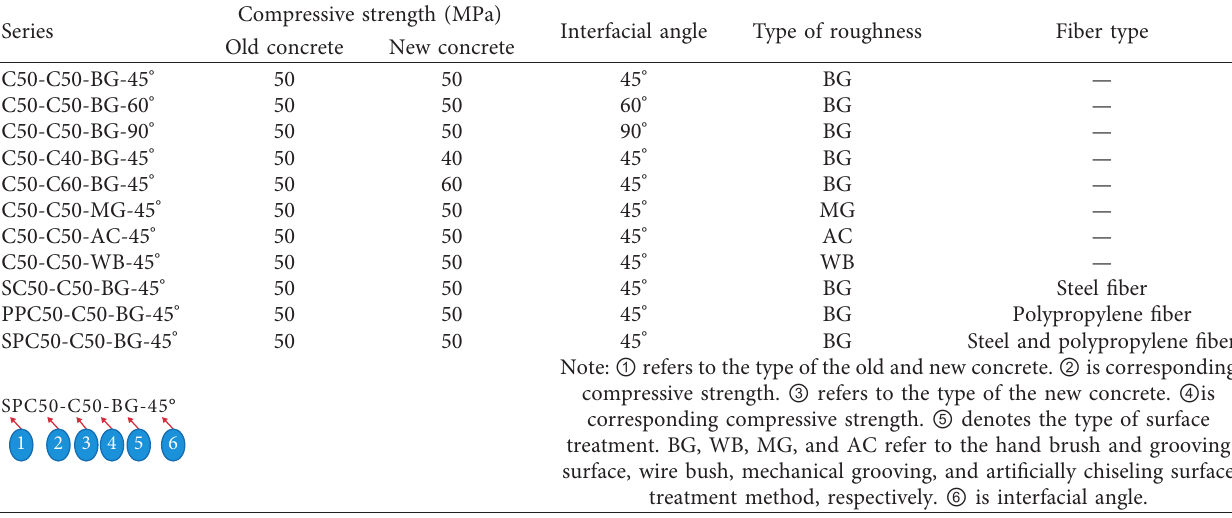
Table 1: Parameters of direct tension static test specimens.